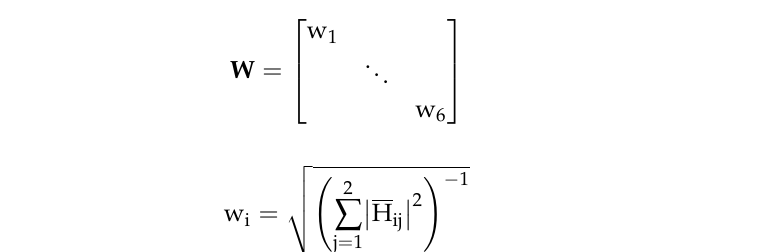
Figure 5. Measured random acceleration